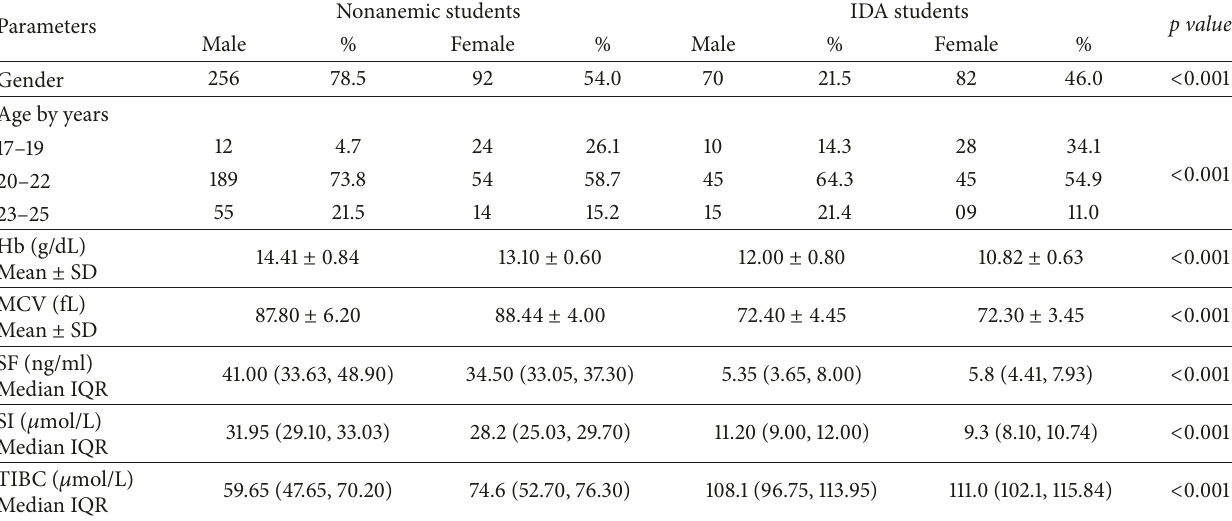
Table 1: Levels of Hb, MCV, SF, SI, and TIBC parameters and prevalence of iron deficiency anemia among Yemeni University students according to age and gender.